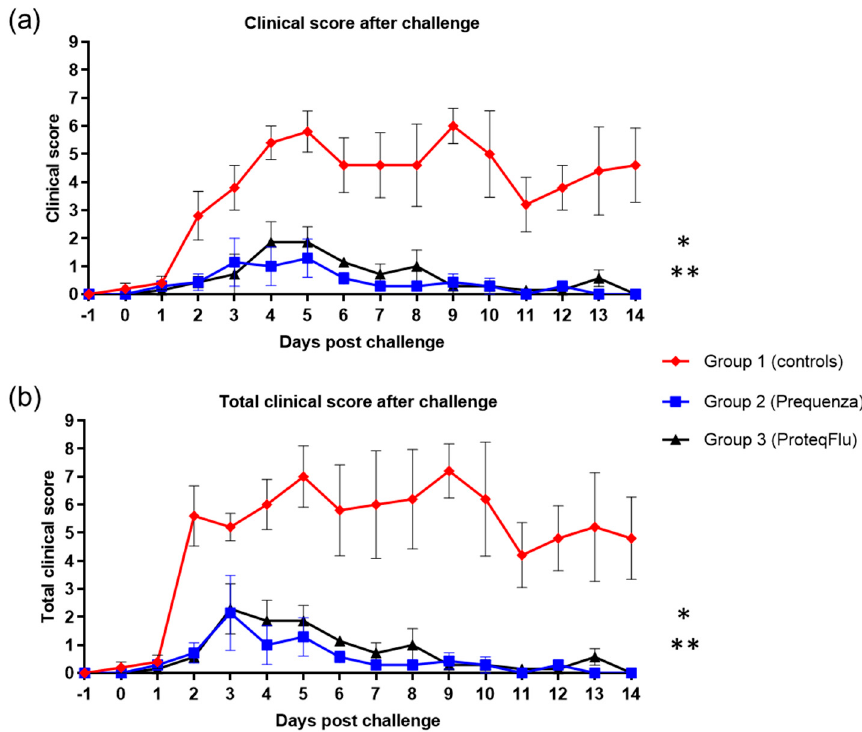
Figure 6. ( a ) Clinical score (clinical score excluding rectal temperature) and ( b ) Total clinical score (clinical signs and rectal temperature) in groups 1–3 after challenge with H3N8 A/equi-2/Wexford/14 (FC2 sublineage). Red diamond = group 1, unvaccinated control group; blue square = group 2, Equilis Prequenza-vaccinated group; black triangle = group 3, ProteqFlu-vaccinated group. Error bars represent SEM. Inferential statistics: significant difference ( p < 0.05) between groups 1 and 2 (*) and groups 1 and 3 (**) (mean effect between 1 and 14 dpc).